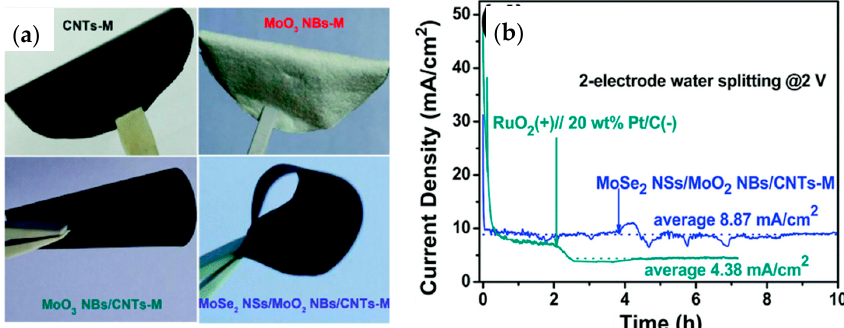
Figure 21. ( a ) Photos of the flexible porous membranes of MoSe 2 NS/MoO 2 NB/CNT-M and the individual components. ( b ) Stability in acidic media using as anode and cathode the MoSe 2 NS/MoO 2 NB/CNT-M electrode. Reprinted with permission from [216]. Copyright 2018, The Royal Society of Chemistry.